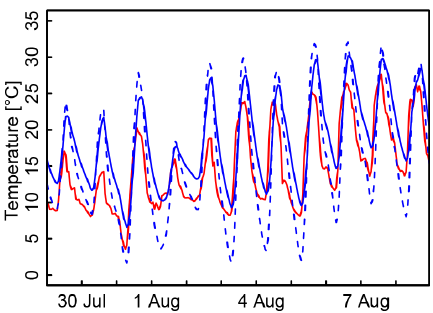
Figure 9. Air temperature (red) and surface temperature simulated for the Fluela snow heap with 40cm (solid blue) and 20cm (dashed blue) sawdust layer over 4 days in August.